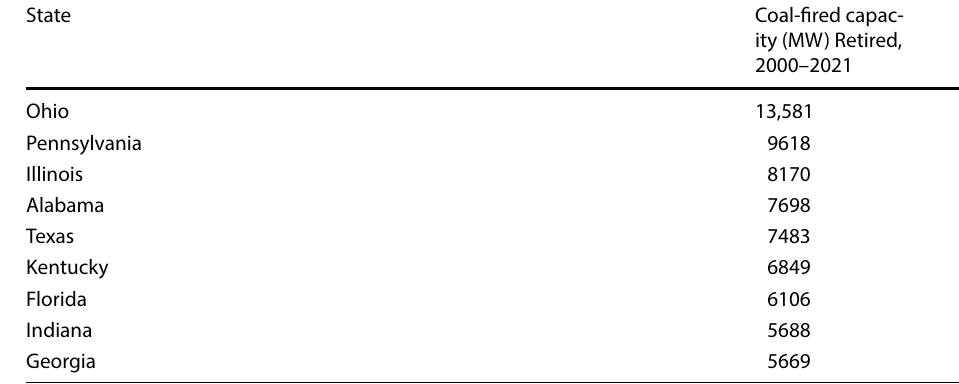
Table 2 Nine largest coal-fired capacity retirements by state,